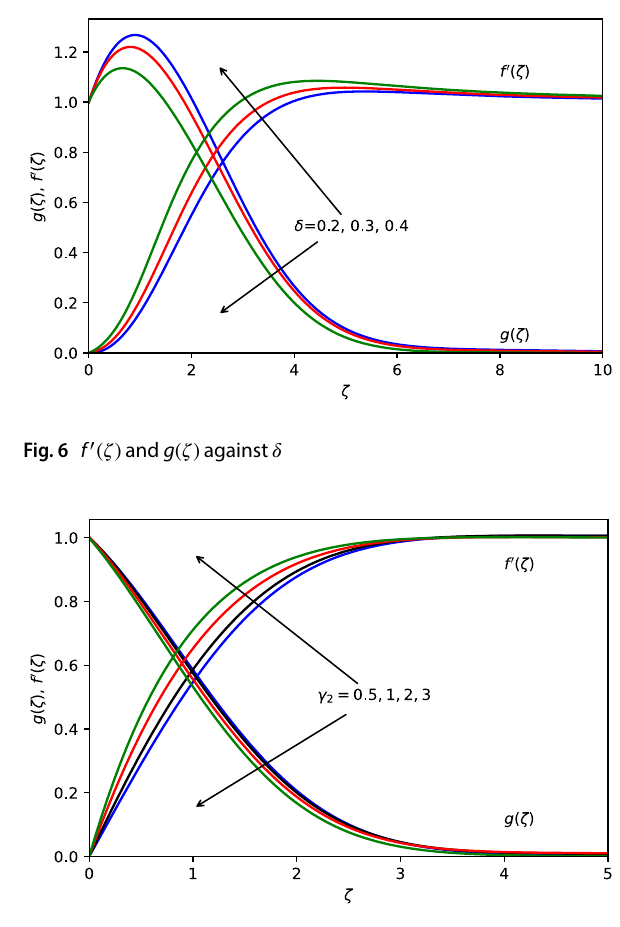
Fig. 7 f � ( 𝜁 ) and g ( 𝜁 ) against 𝛾